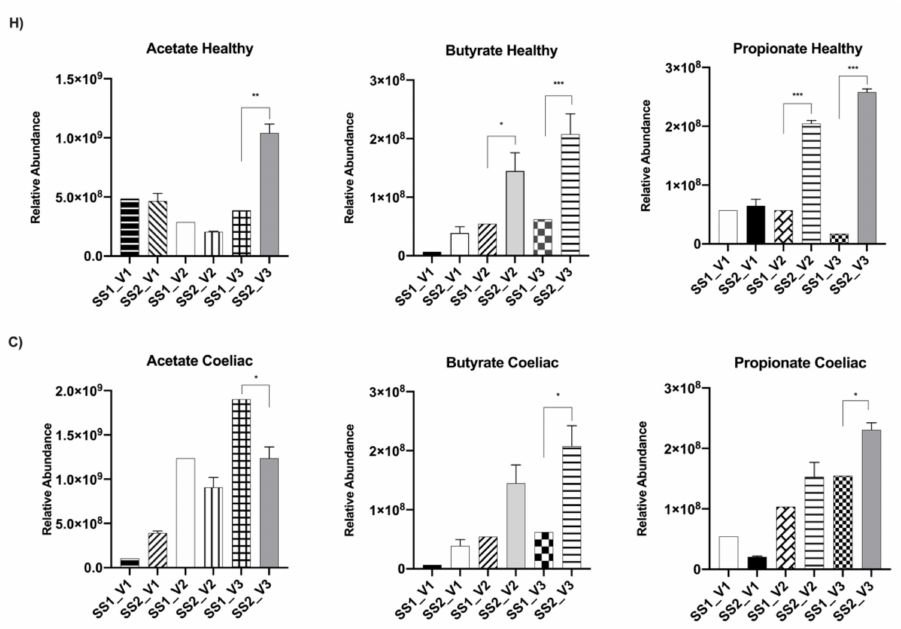
Figure 4. The faecal-derived microbial SCFAs (acetate, butyrate, propionate) of the healthy ( n = 1) and Coeliac ( n = 1) donors in fermentation experiments in the presence of C. pyrenoidosa extract (Sun Chlorella ‘A’ Powder). ( H ) 1 H-NMR analysis of SCFAs relative abundance in vessels (V1, V2, V3) from healthy donor before (SS1) and following fermentation with C. pyrenoidosa extract (Sun Chlorella ‘A’ Powder). (SS2) (3 g/day). Significance of one-way ANOVA with Tukey’s posthoc comparison after treatment: * p < 0.05; ** p < 0.001 and *** p < 0.0001. ( C ) 1 H-NMR analysis of SCFAs relative abundance in vessels (V1, V2, V3) from Coeliac donor before (SS1) and following fermentation